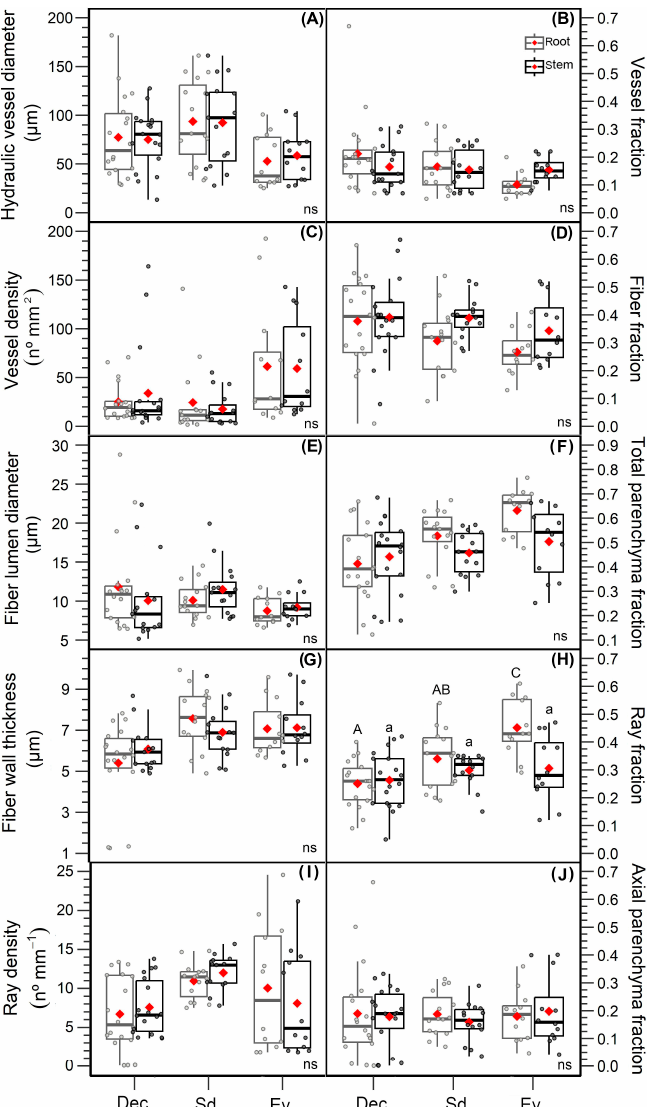
Figure 4. Anatomical xylem traits(i.e., hydraulic vessel diameter ( A ); vessel fraction ( B ); vessel density ( C ); fiber fraction ( D ); fiber lumen diameter ( E ); total parenchyma fraction ( F ); fiber wall thickness ( G ); ray fraction ( H ); ray density ( I ); axial parenchyma fraction ( J )) as function of leaf habit senescence and organs of the studied Cerrado species (N = 15). Roots and stems are shown in gray and black, respectively. Boxplots show the average (red diamond), individual data points (dots), and median (horizontal line); lower and upper boxplots represent the 25th and 75th percentiles; and whiskers represent 1.5× the interquartile range. Different letters indicate a significant difference among leaf habits for a given organ according to Bonferroni post hoc test ( p < 0.05); uppercase: root, lowercase: stem. ns = not significant. Dec, deciduous; Sd, semi-deciduous; Ev, evergreen.